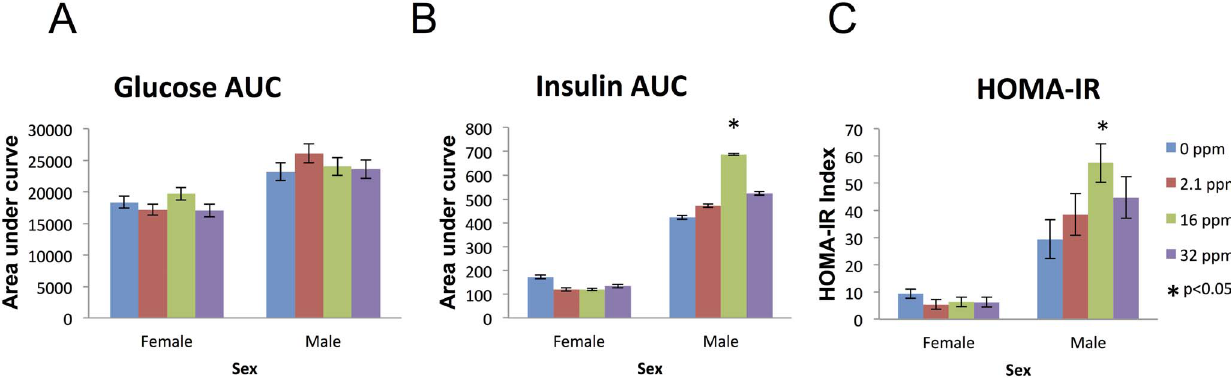
Figure 5. Blood Insulin and Glucose (9 months). (A) Glucose (mg/dl) measured by a fasting oral glucose tolerance AUC did not differ in either males or females. (B) Insulin (ng/ml) is increased in males at the medium exposure area under the curve (AUC) and (C) Homeostatic Model Assessment of Insulin Resistance (HOMA-IR). Calculated from baseline blood insulin and glucose levels, indicates an index of insulin resistance. Males at the medium exposure level show a significant increase in HOMA-IR as over control. Single stars indicate p-values , 0.05, when compared to controls. Bars represent standard error.